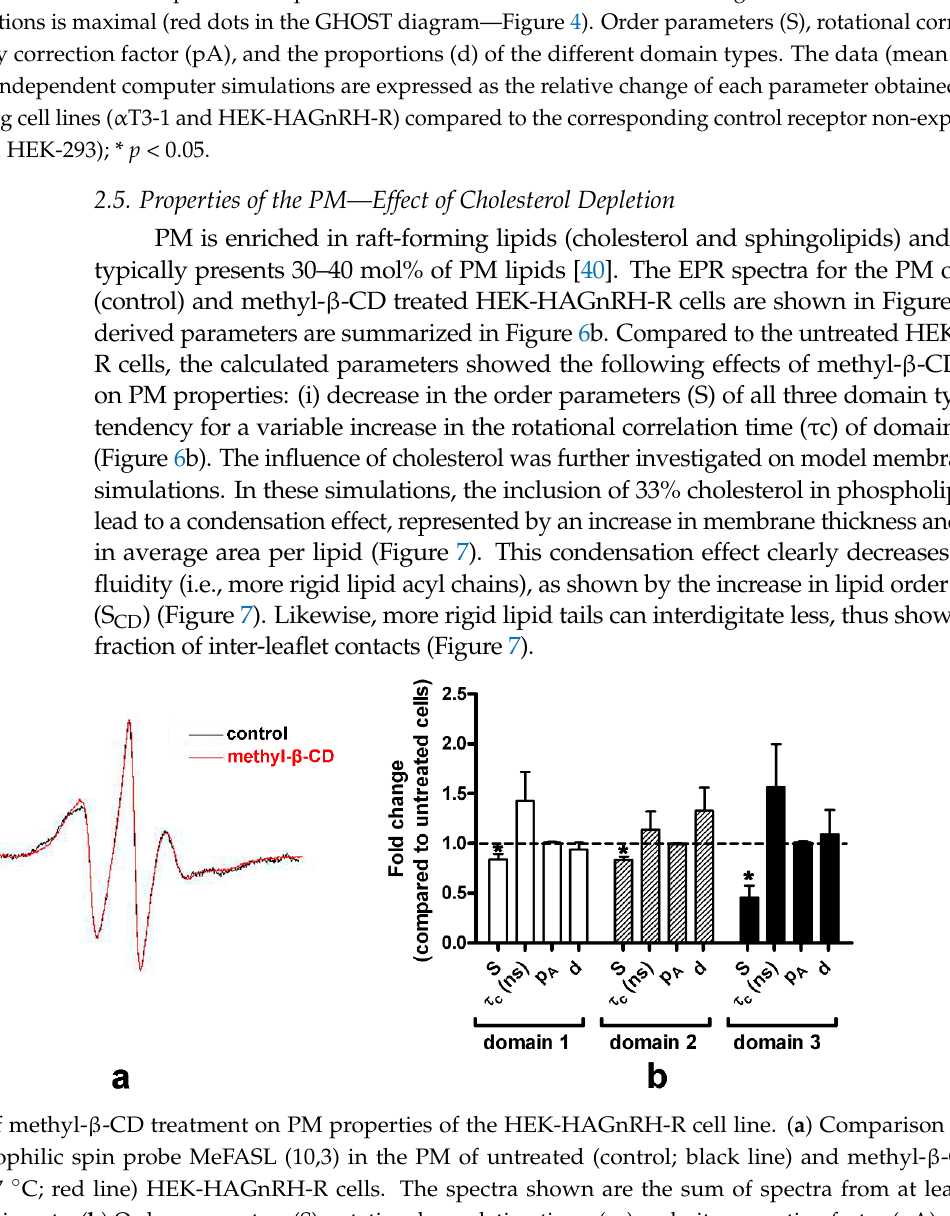
Figure 5. Order parameters (S), rotational correlation times ( τ c), polarity correction factor (pA), and the proportions (d) of the different domain types in the pituitary gonadotrope and heterologous GnRH-R expressing cell line. The parameters of the best fit of the calculated to the experimental spectra were determined from the GHOST diagrams as a value at which the density of the solutions is maximal (red dots in the GHOST diagram—Figure 4). Order parameters (S), rotational correlation times ( τ c), polarity correction factor (pA), and the proportions (d) of the different domain types. The data (mean ± S.E.) from at least four independent computer simulations are expressed as the relative change of each parameter obtained in the GnRH-R expressing cell lines ( α T3-1 and HEK-HAGnRH-R) compared to the corresponding control receptor non-expressing cell lines ( α T4 and HEK-293); * p < 0.05.